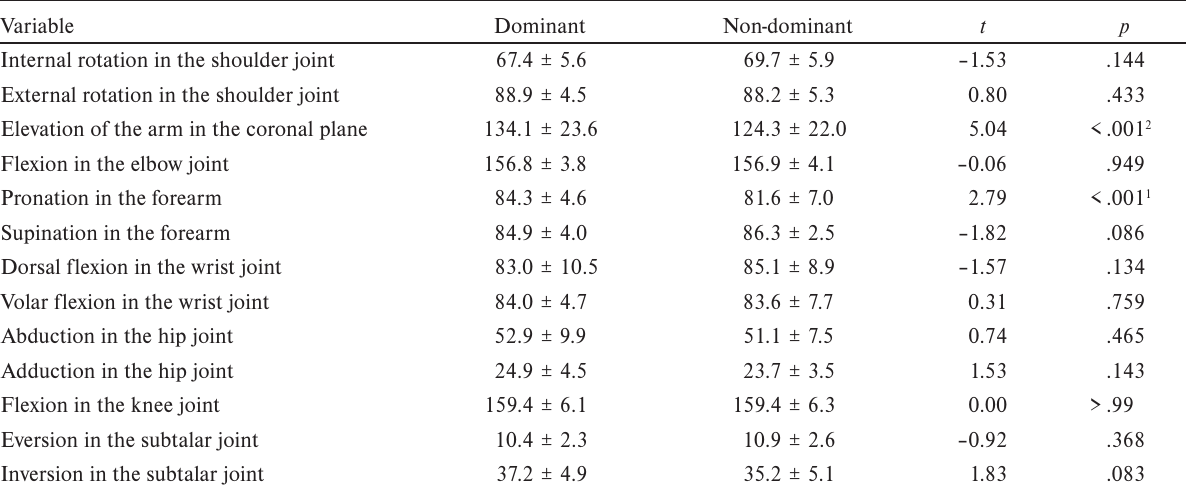
Table 2 Differences in range of motion between the dominant and non-dominant joint after match play. Values are presented in degrees as mean ±